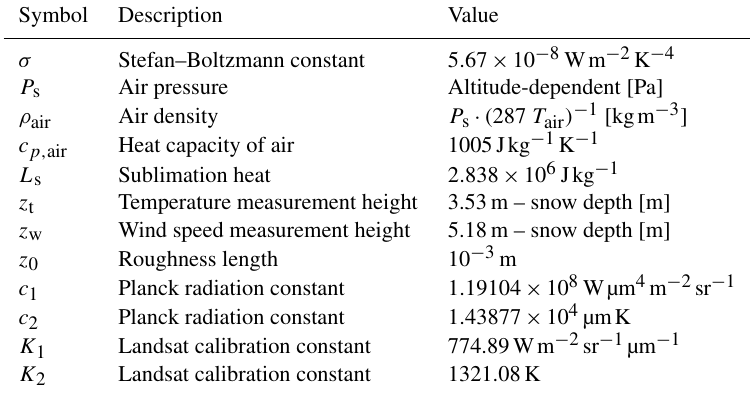
Table B1. Definitions and values of the symbols and magnitudes that appear in this paper.